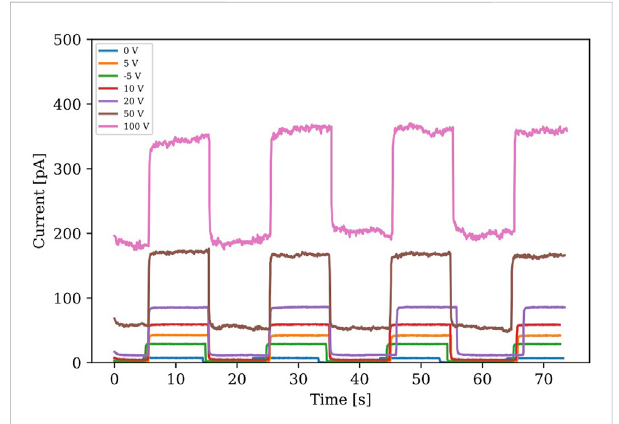
FIGURE 11 X-ray induced single charge carrier Hecht fi tting of a Ag/ Cs 3 Bi 2 Br 9 /Ag device.